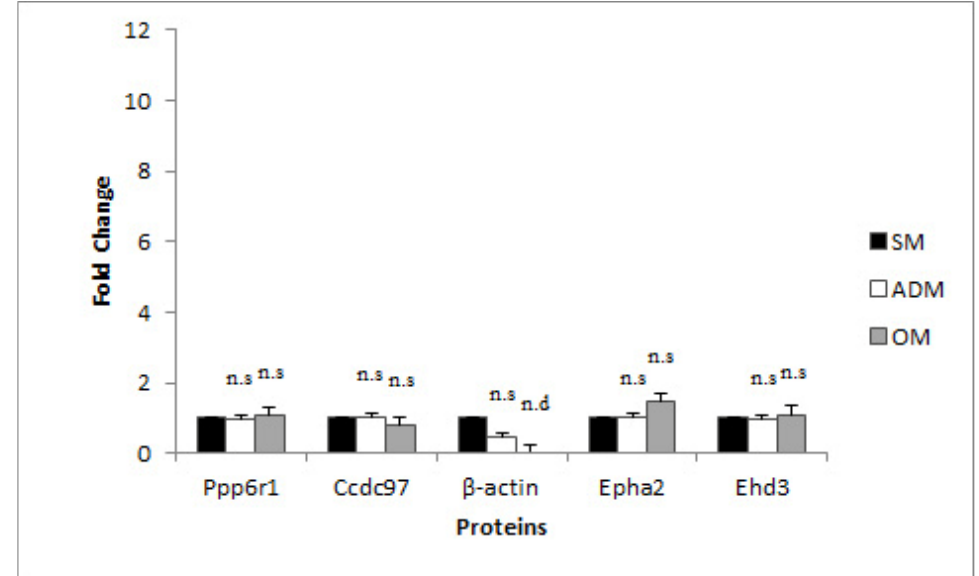
Figure 3. Relative protein expression for RG candidates selected by evaluation of ADSC, AD, and OB proteomes; the relative protein expression across conditions for β‐ actin is also reported. n.s. = not significant, n.d. = not detected.